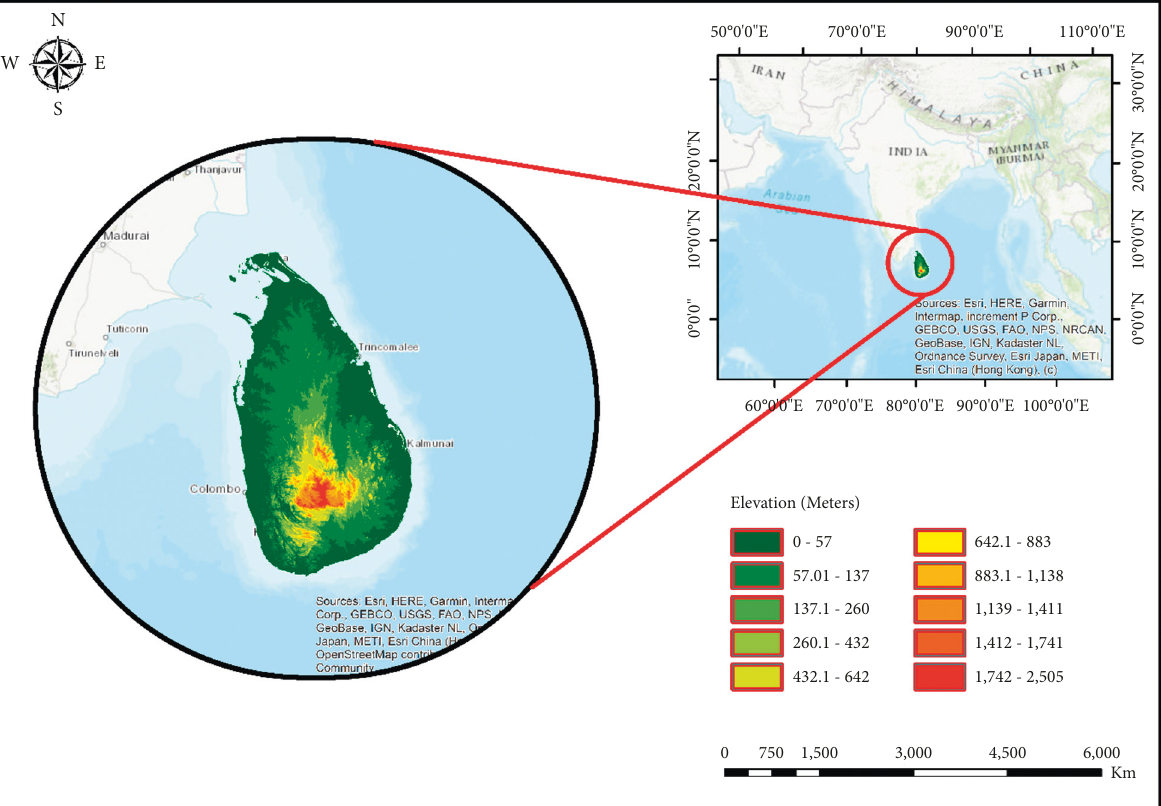
Figure 1: Study area of the research and its